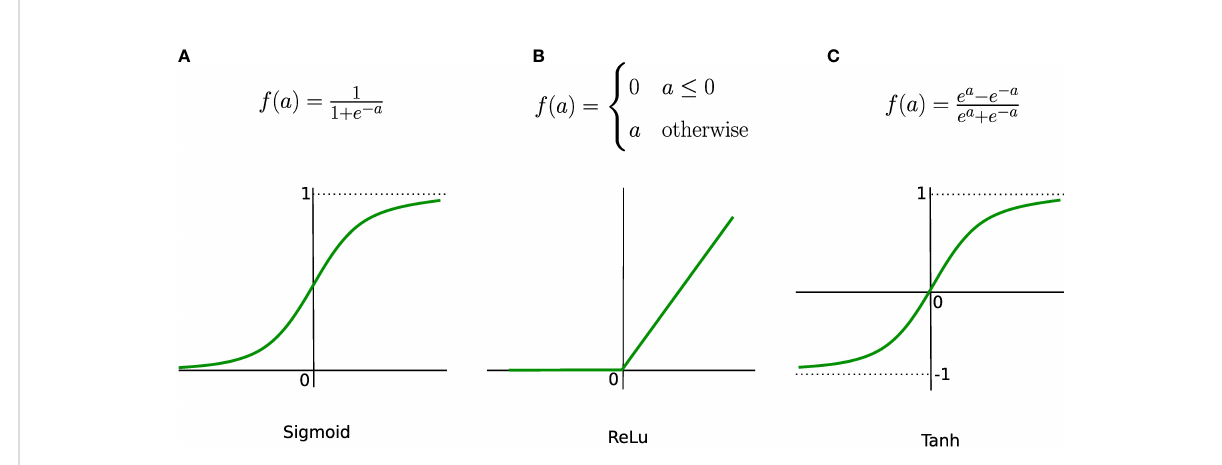
FIGURE 3 Most common activation functions. (A) Sigmoind, (B) ReLu and (C)